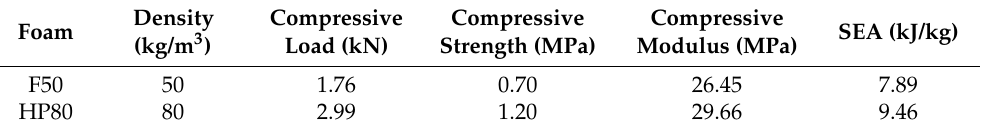
Table 3. Compression properties of